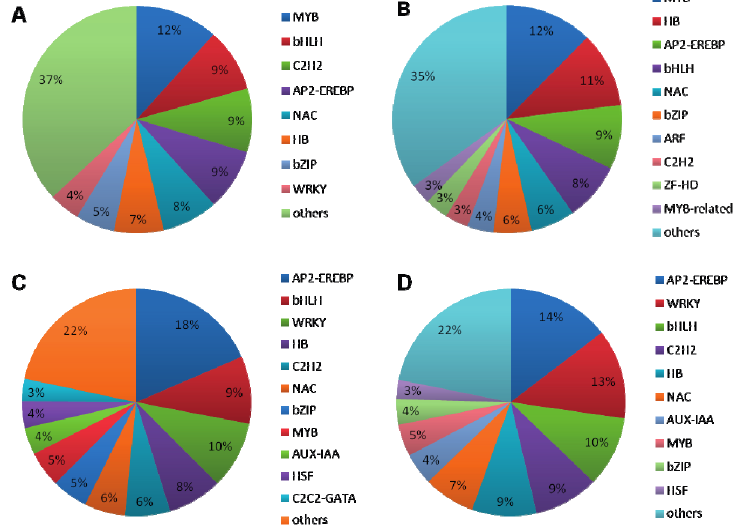
Figure 6. Distribution of transcription factor gene families in B. napus . ( A ) Distribution of transcription factors specially expressed in root; ( B ) Distribution of transcription factors specially expressed in leaf; ( C ) Distribution of transcription factors expressed both in root and leaf; ( D ) Distribution of transcription factors conversely expressed in root and